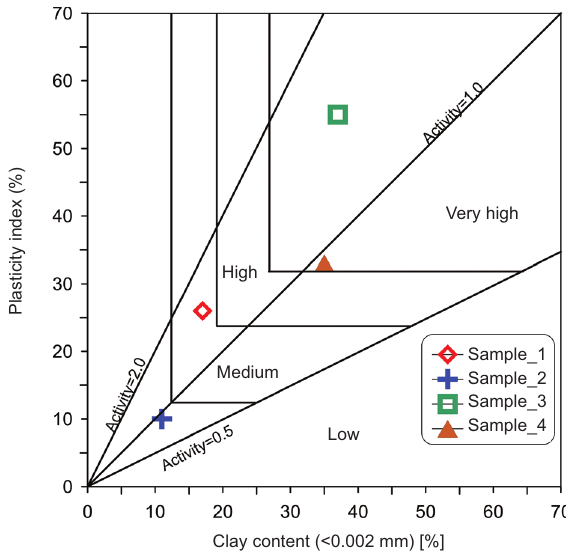
Figure 6 Classification chart, proposed by Van der Merwe [36], used to determine the swelling